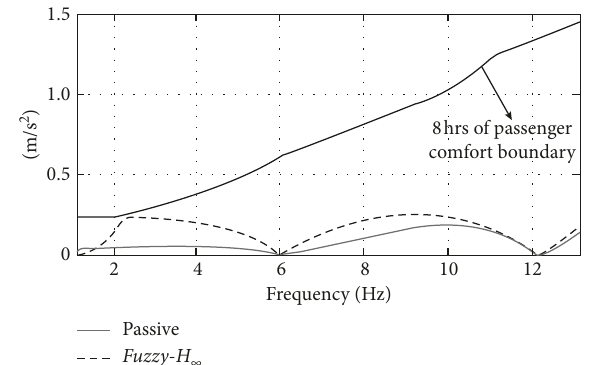
Figure 24: Pitch angle acceleration ( € θ ). The upper wide black line represents the boundary limits to maintain a passenger comfort situation for 8hrs